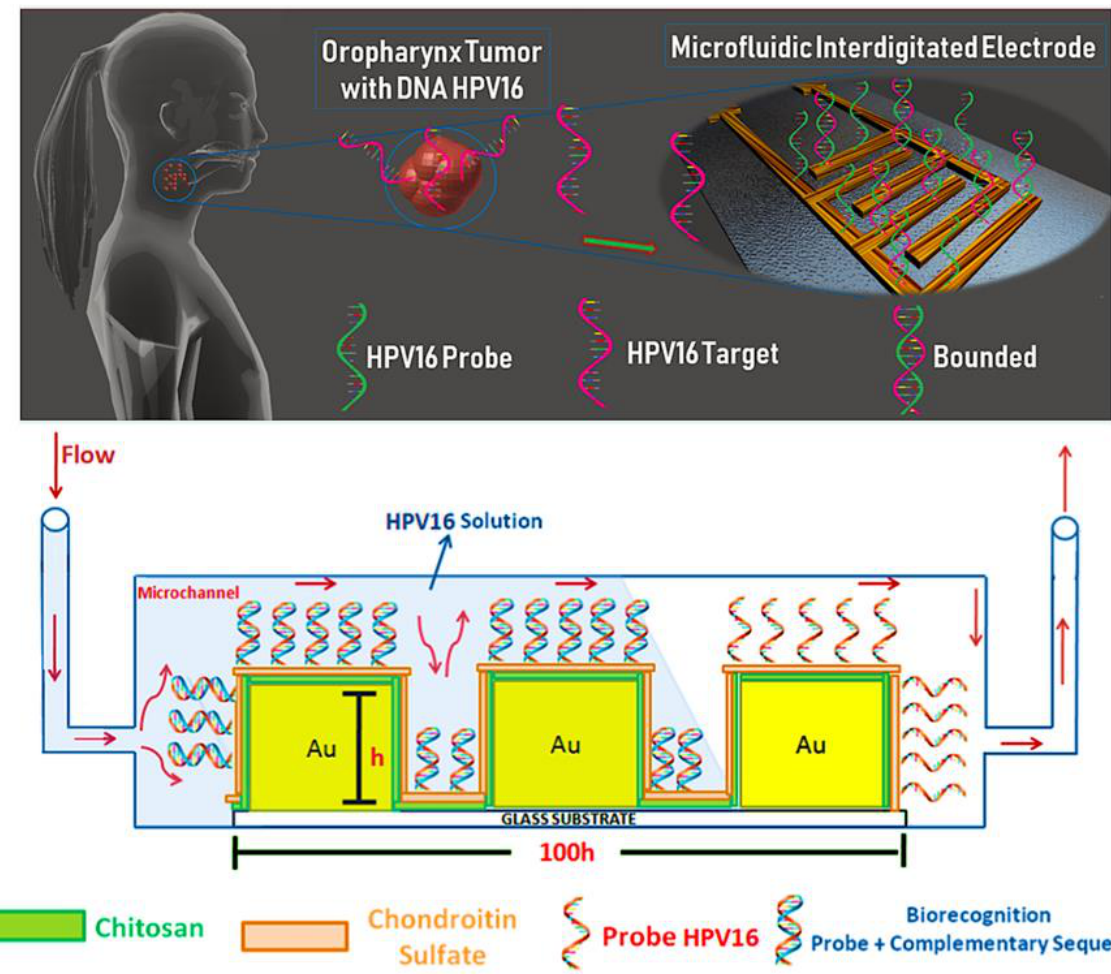
Figure 6. Schematic representation of the functionalization of the electrode and detection of HPV16 under continuous flow [98].